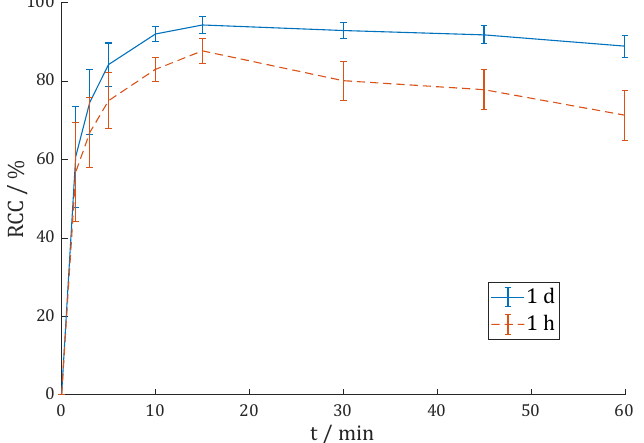
Figure 5. Reaction kinetics (radiochemical conversion (RCC) in %) of [ 225 Ac]Ac-DOTAGA.Glu.(FAPi) 2 225 Ac ‐ 7 in 0.1 M sodium ascorbate (pH = 7.0) at 95 °C with 1.6–3.2 MBq 225 Ac (n = 3).